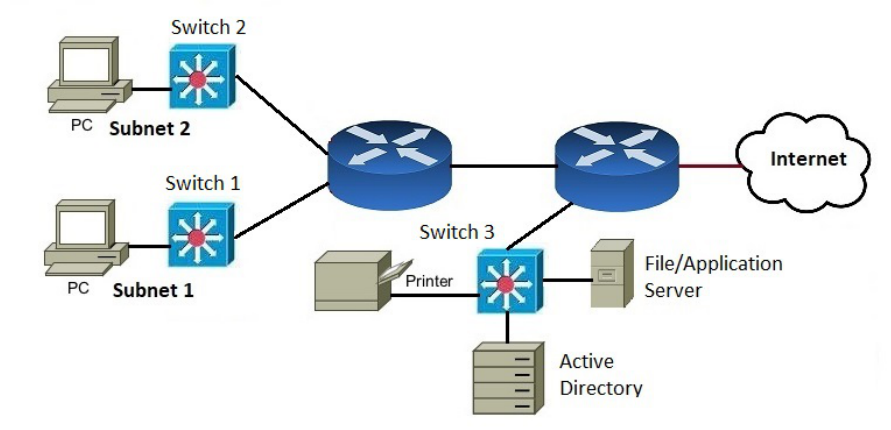
Figure 5. Potential challenges and Configuration issues: Experiment 1.